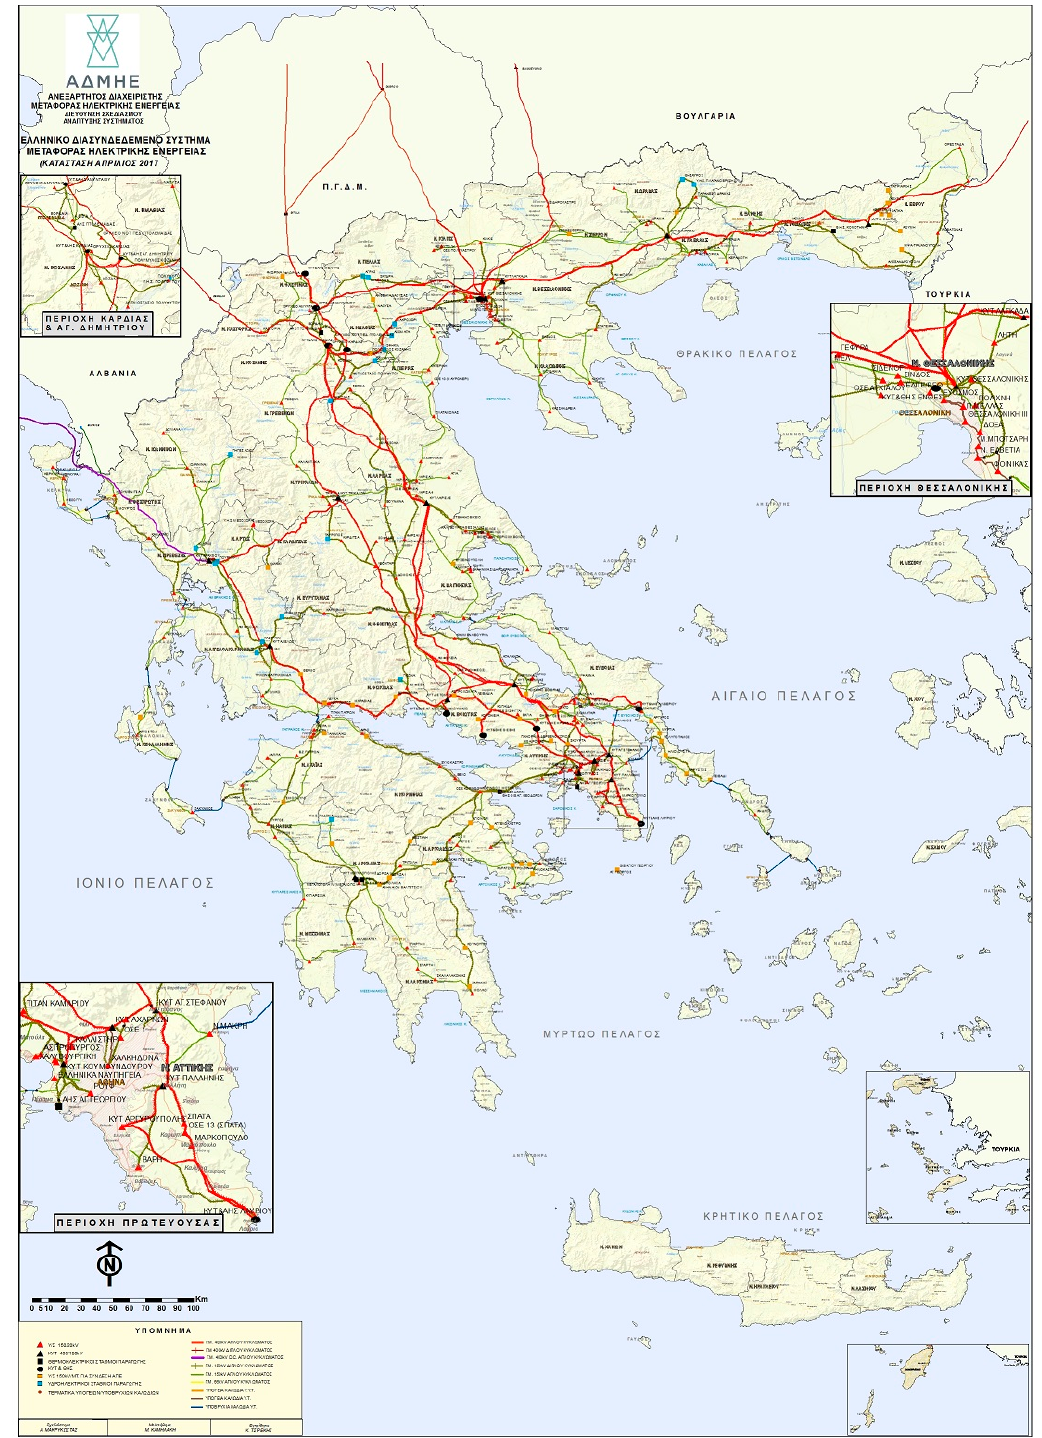
Figure 6. Interconnections of the Greek electricity transmission system